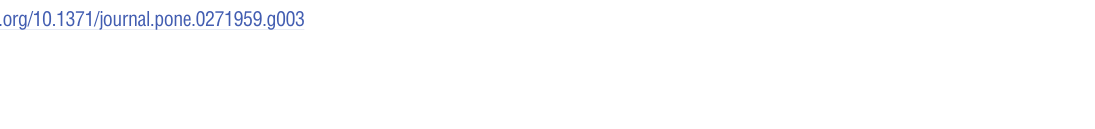
PLOS ONE | https://doi.org/10.1371/journal.pone.0271959 August 4,